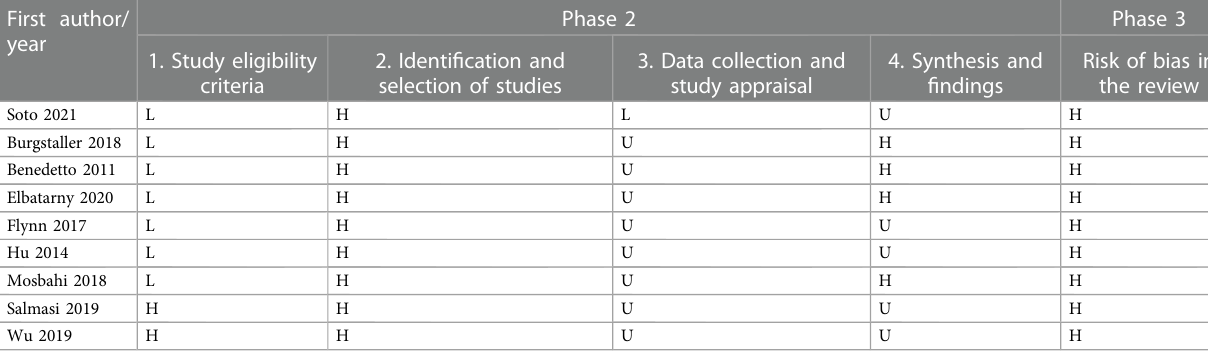
TABLE 5 Risk of bias of the included systematic reviews assessed by risk of bias in systematic reviews.